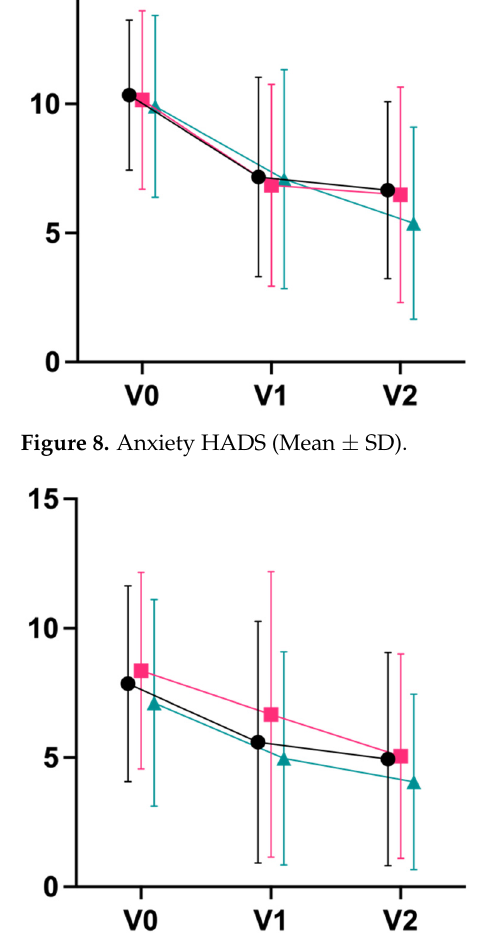
Figure 9. Depression HADS (Mean ± SD).